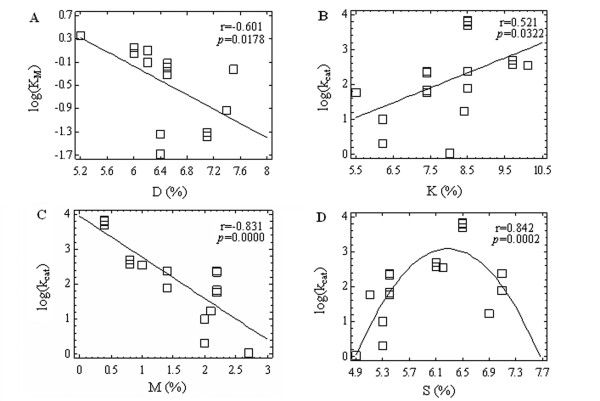
The relationships between kinetic constants and the frequencies of individual AA. Bivariate correlations between the log-values of kinetic constants and frequencies of occurrence for individual AA in the yeast S. cerevisiae enzyme sequences, where KM is the Michaelis-Menten constant (A) and kcat is the catalytic constant (B–D). All the linear correlations are significant at the non-parametric assessment (Kendall’s τ, Spearman’s ρ correlation coefficients).